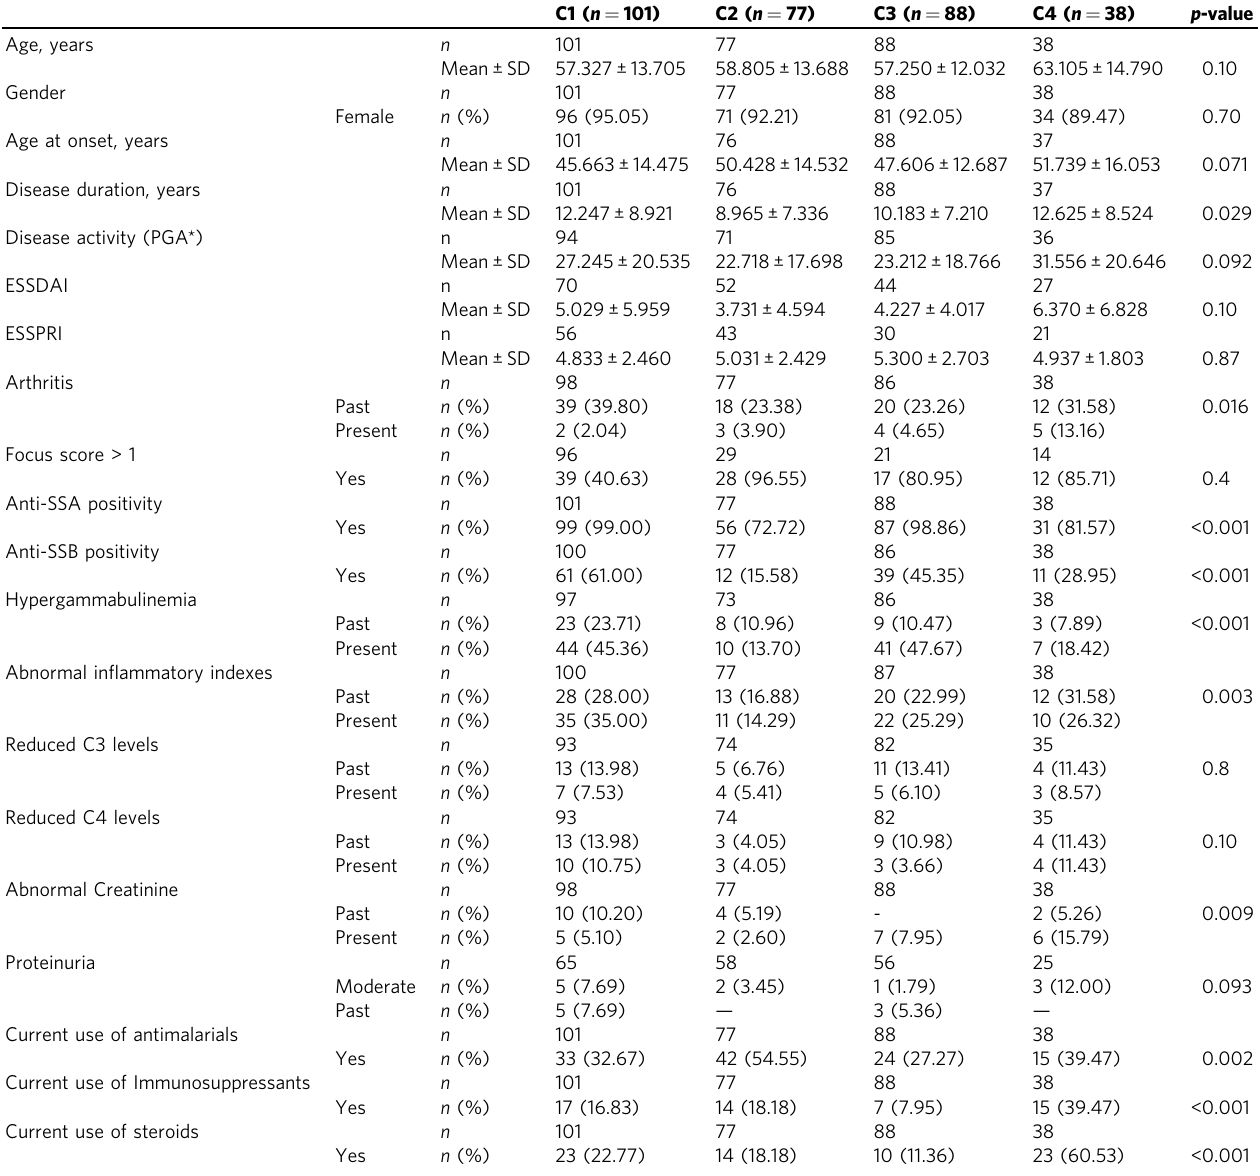
Table 2 Descriptive analysis of the clinical parameters by primary Sjögren ’ s syndrome